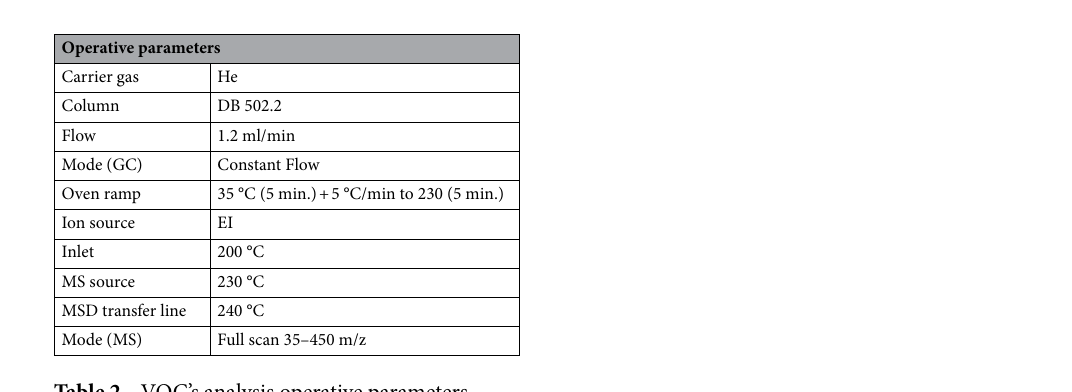
Table 2. VOC’s analysis operative